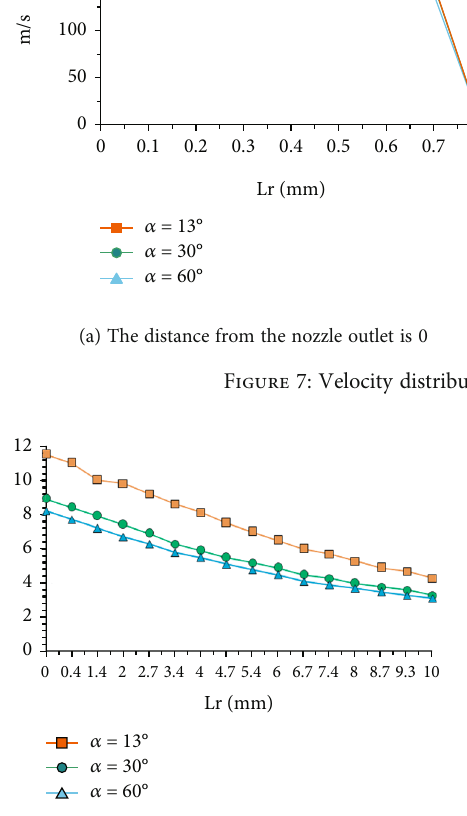
Figure 8: Pressure distribution of the water jet on the central axis. Figure